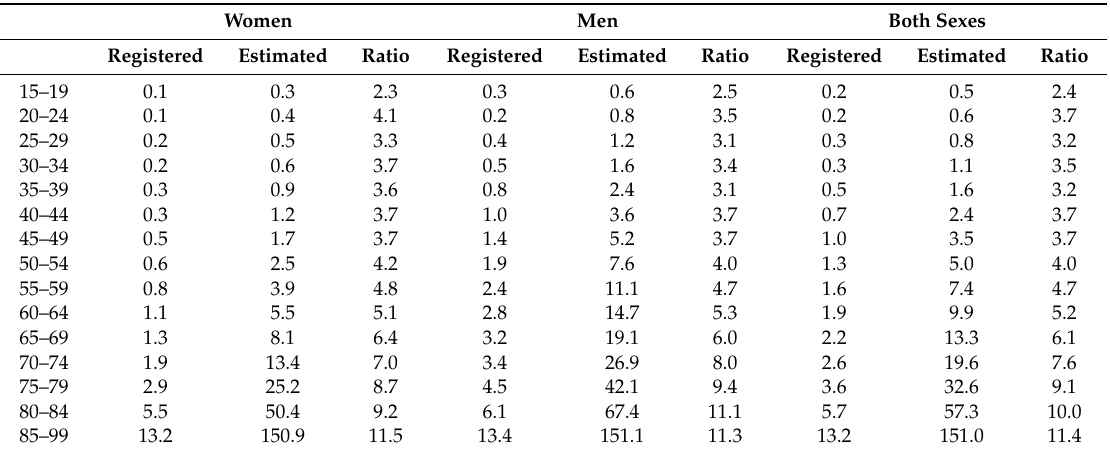
Table A5. Mortality rates of registered and estimated deaths of all cardiomyopathies by sex and age.